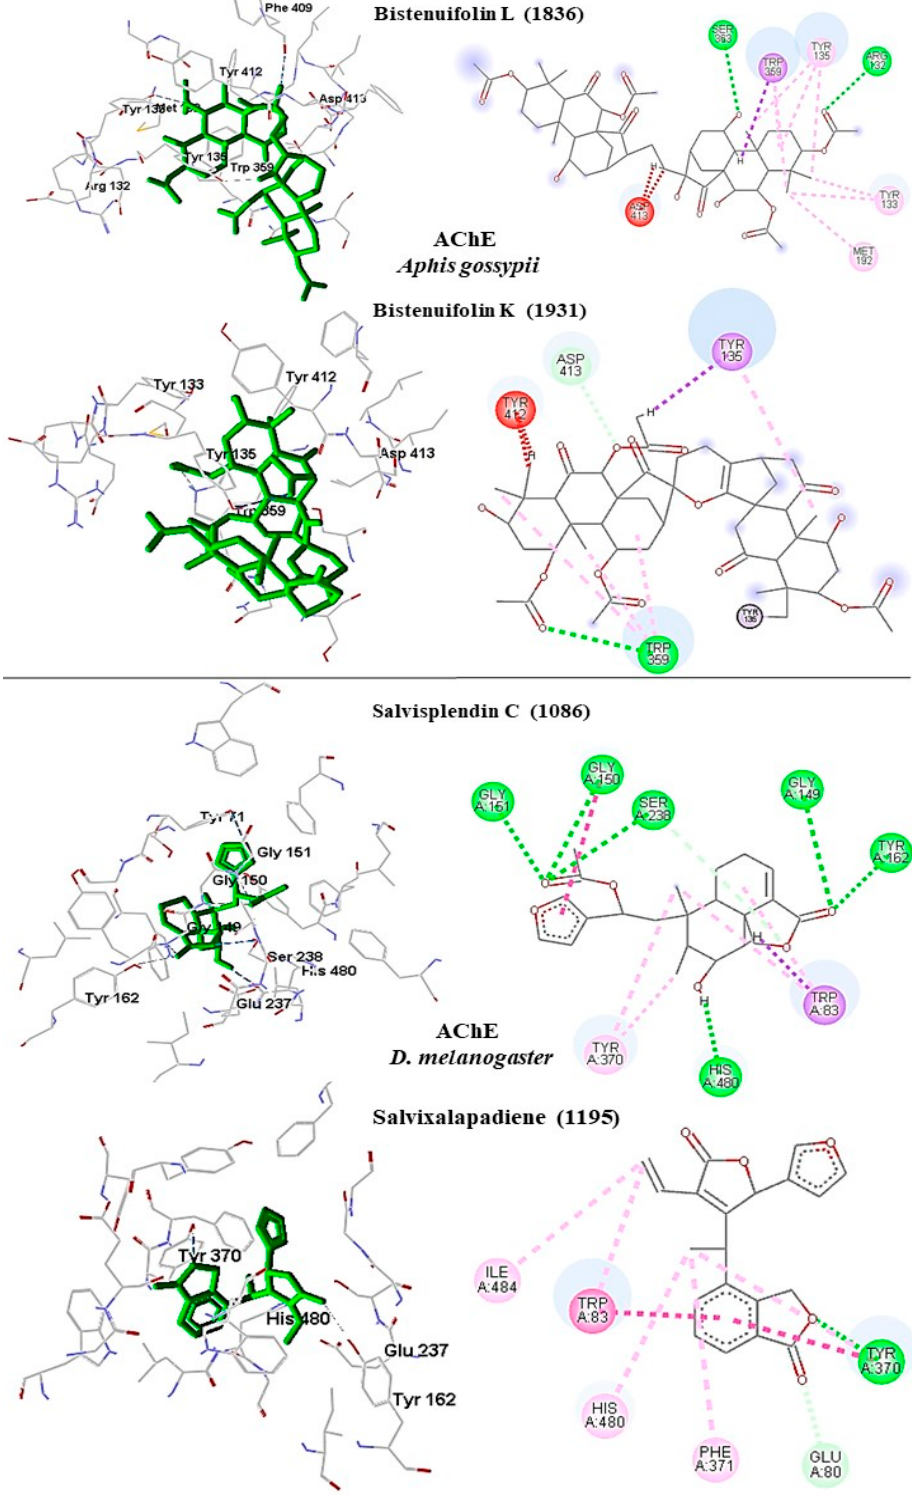
Figure 7. Interactions (3D and 2D) between 1836 and 1931 and A. gossypii -AchE; and between 1086 and 1195 and D. melanogaster -AChE. Hydrogen bonds are highlighted in green, hydrophobic interactions are highlighted in pink, and steric interactions are highlighted in red.